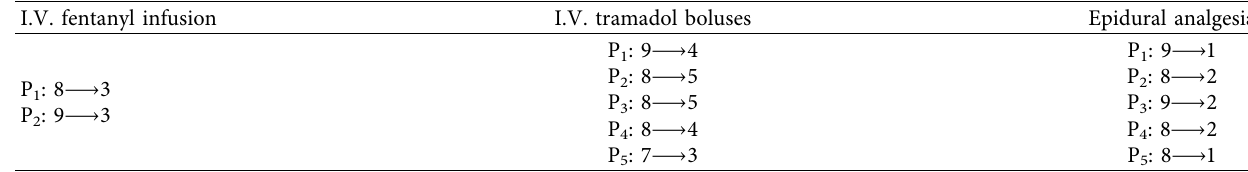
Table 4: Change in VAS scores of patients with respect to the mode of